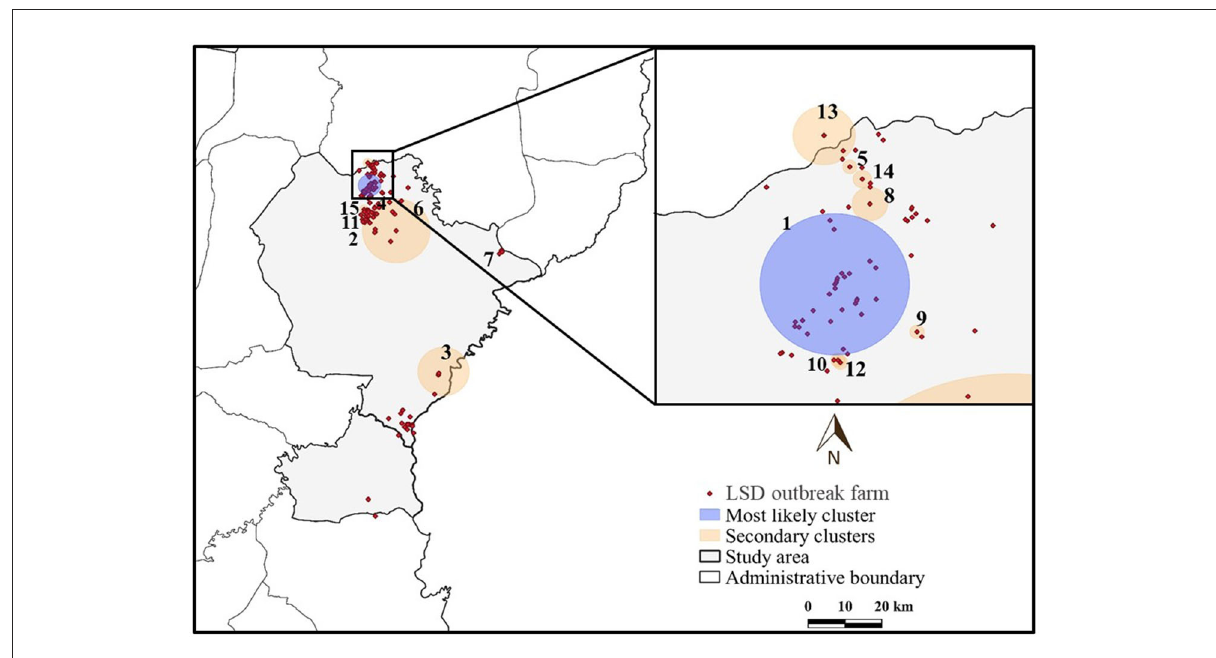
FIGURE3 Spatio-temporal clusters of lumpy skin disease (LSD) outbreaks in dairy farms, Khon Kean province, Thailand detected by the space-time permutation